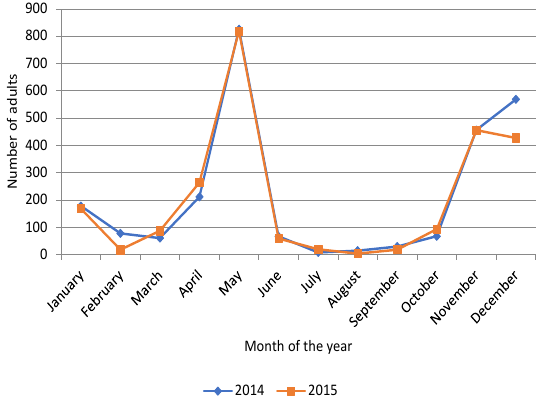
Figure 6. Double row asparagus crop with drip irrigation system between rows.